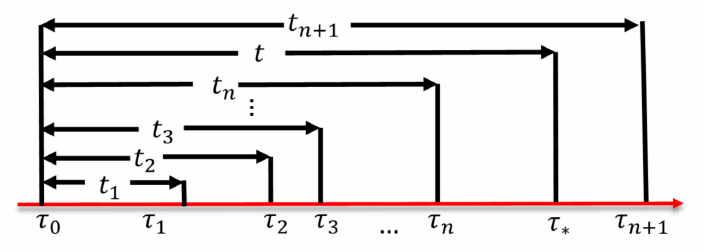
Figure 25. The timing